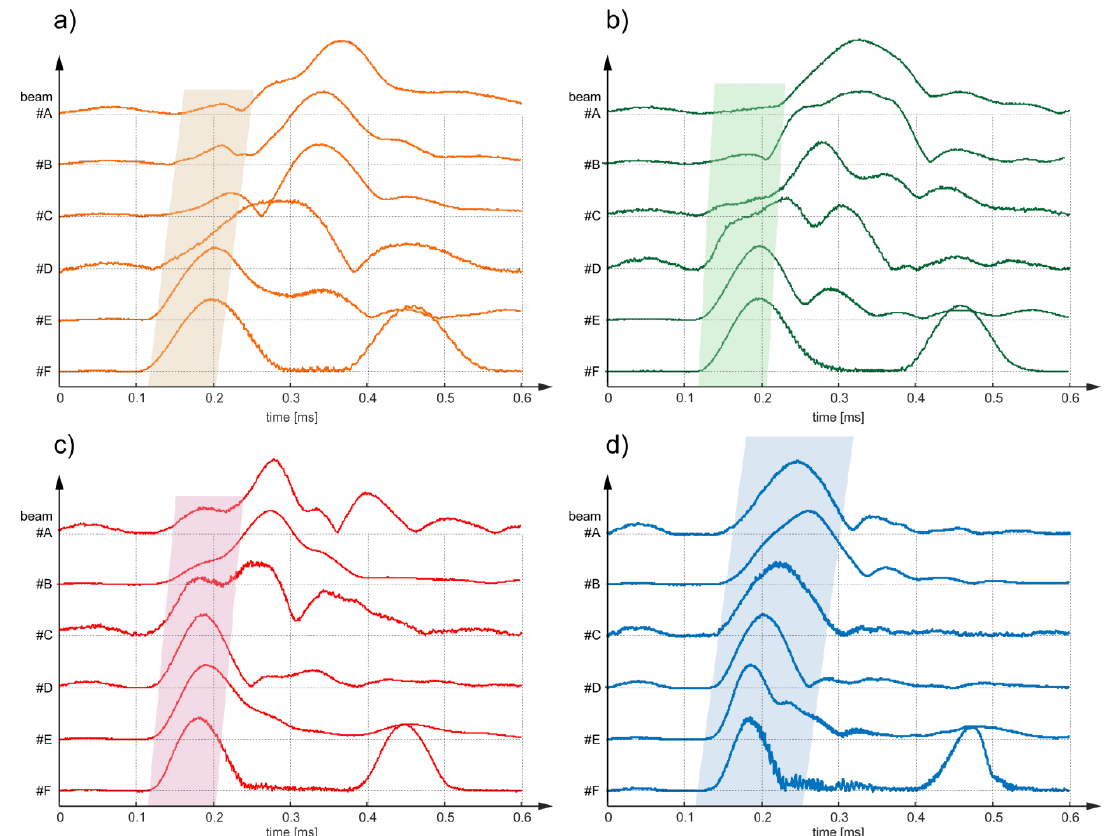
Figure 11. Results of experimental investigations in the form of envelopes of time-domain signals registered at the of beam for excitation frequency equal to ( a ) 50 kHz, ( b ) 60 kHz, ( c ) 70 kHz and ( d ) 90 kHz.